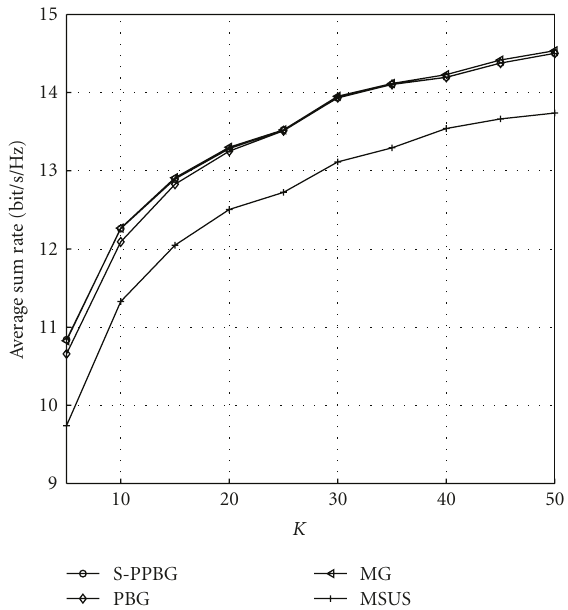
Figure 5: Complexity versus K